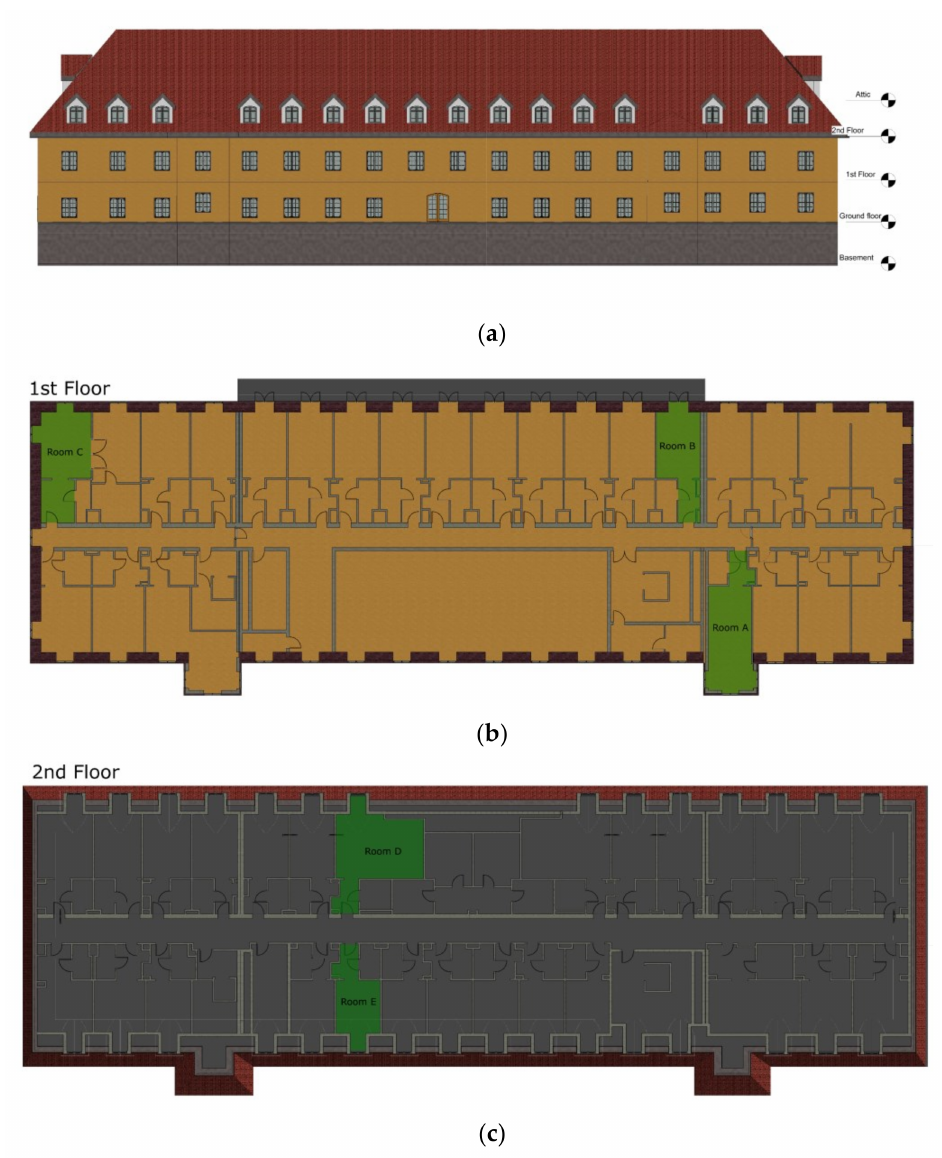
Figure 2. Plans and architectural section of the building: ( a ) Appearance of the facade; ( b ) 1st floor plan; ( c ) 2nd floor